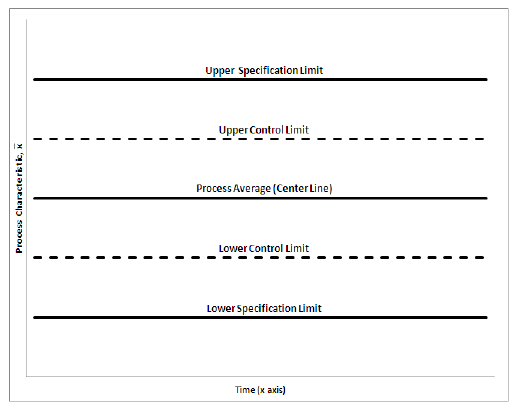
Fig1. Schematic representation of conventional control chart.